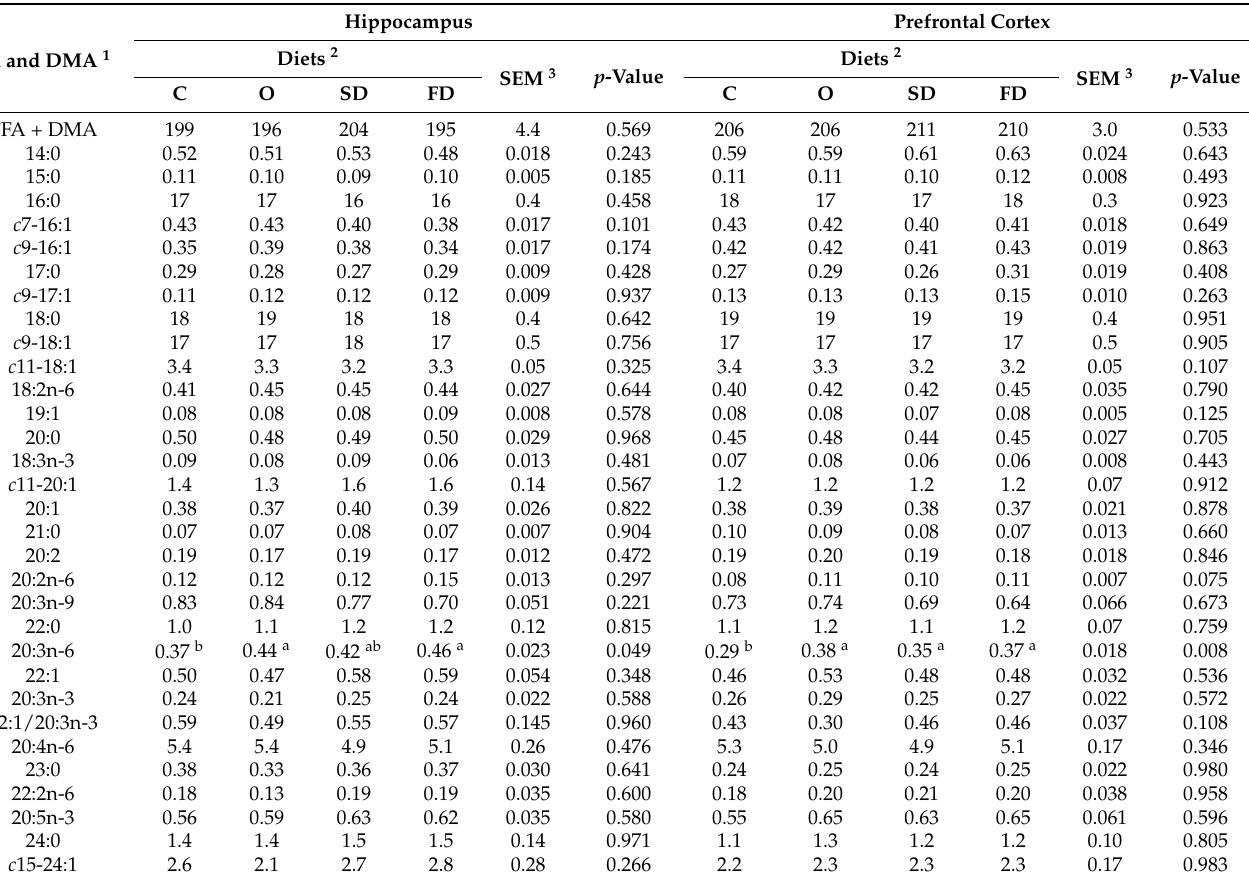
Table 4. Total fatty acid (TFA) and dimethyl acetal (DMA) (mg/g DM) content and composition (% TFA + DMA) of the hippocampus and prefrontal cortex of